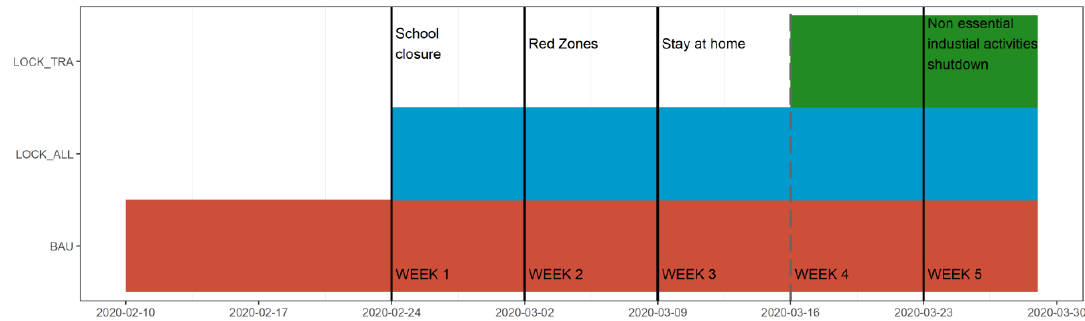
Figure 2. Correlation between the COVID-19 containment measures applied in the Lombardy region and the three simulations of this study.